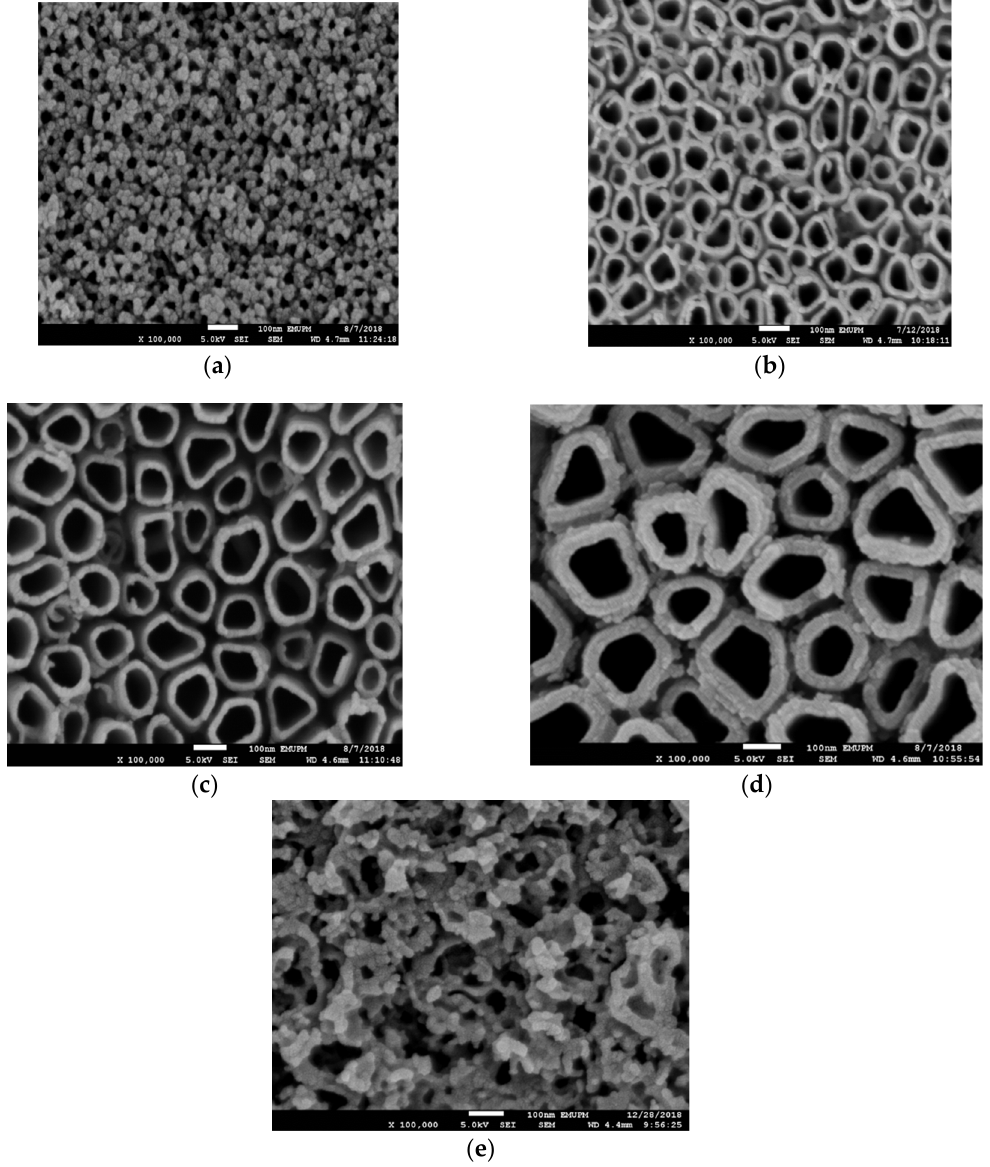
Figure 3. Top view FESEM images of TNTs at the same magnification (×100,000) synthesized at applied voltages of ( a ) 10 V, ( b ) 20 V, ( c ) 30 V, ( d ) 40 V and ( e ) 50 V.